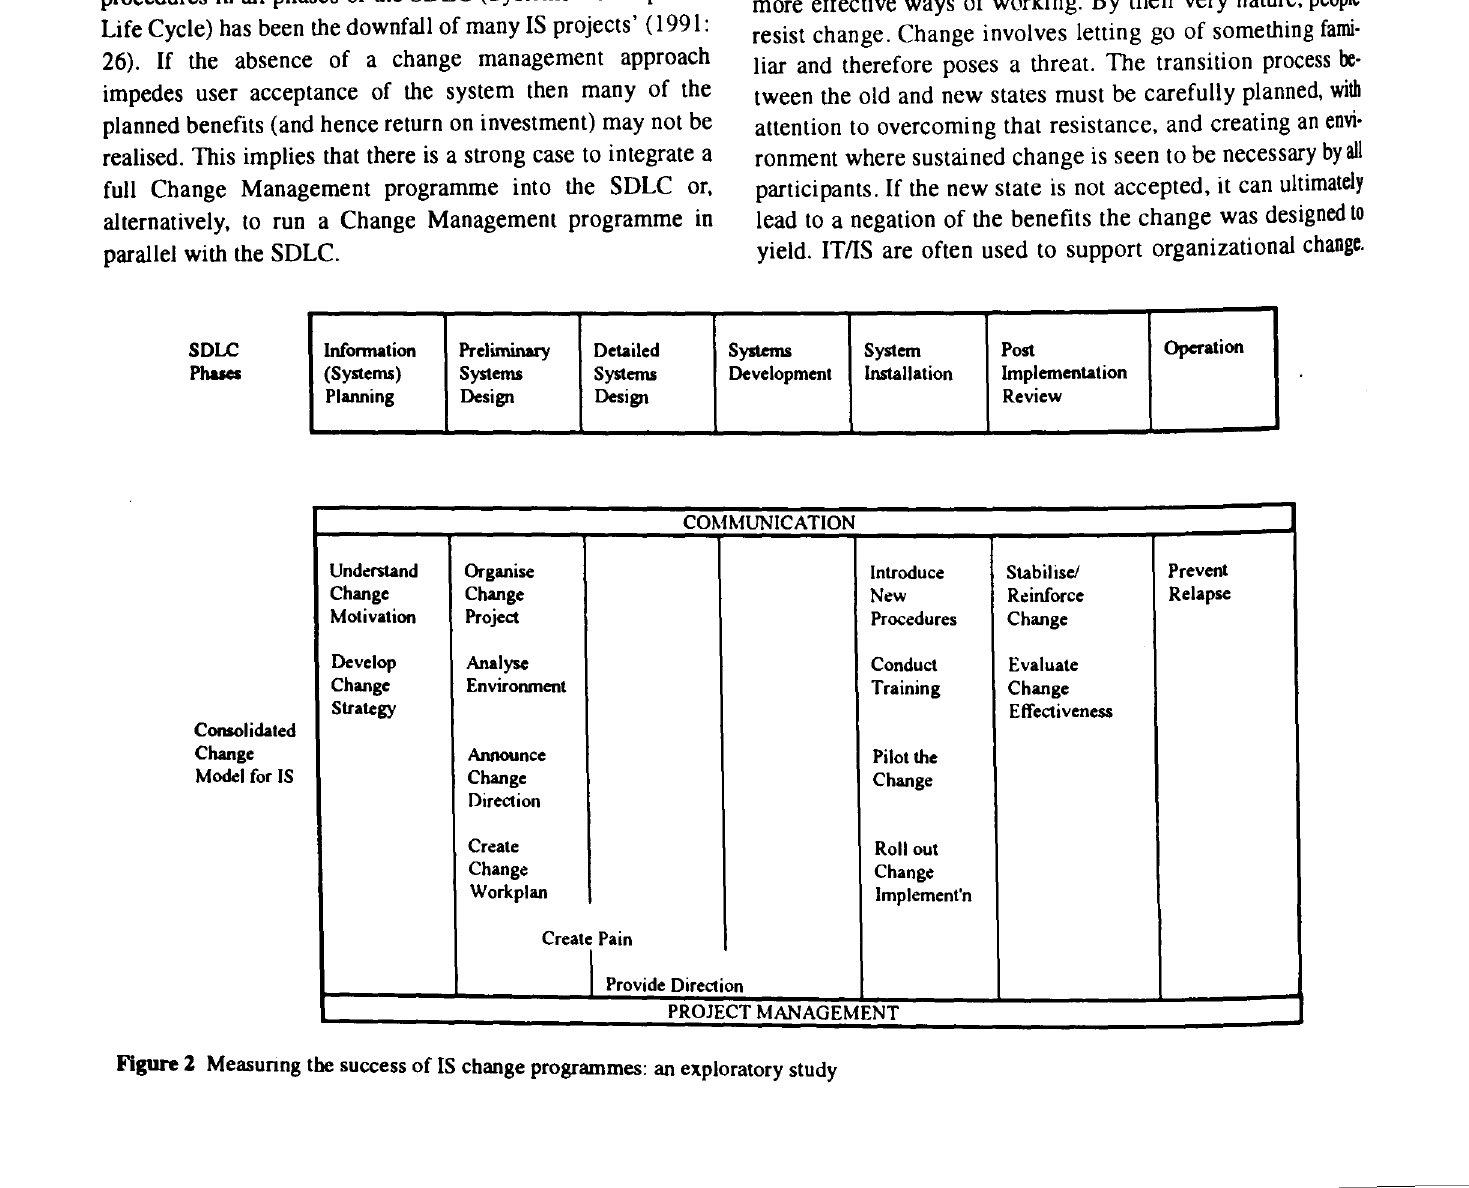
Figure 2 Measunng the success of IS change programmes: an exploratory